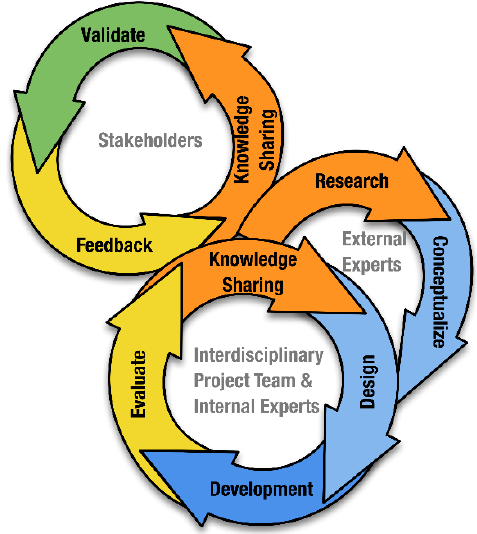
Figure 6. Participatory Approach.